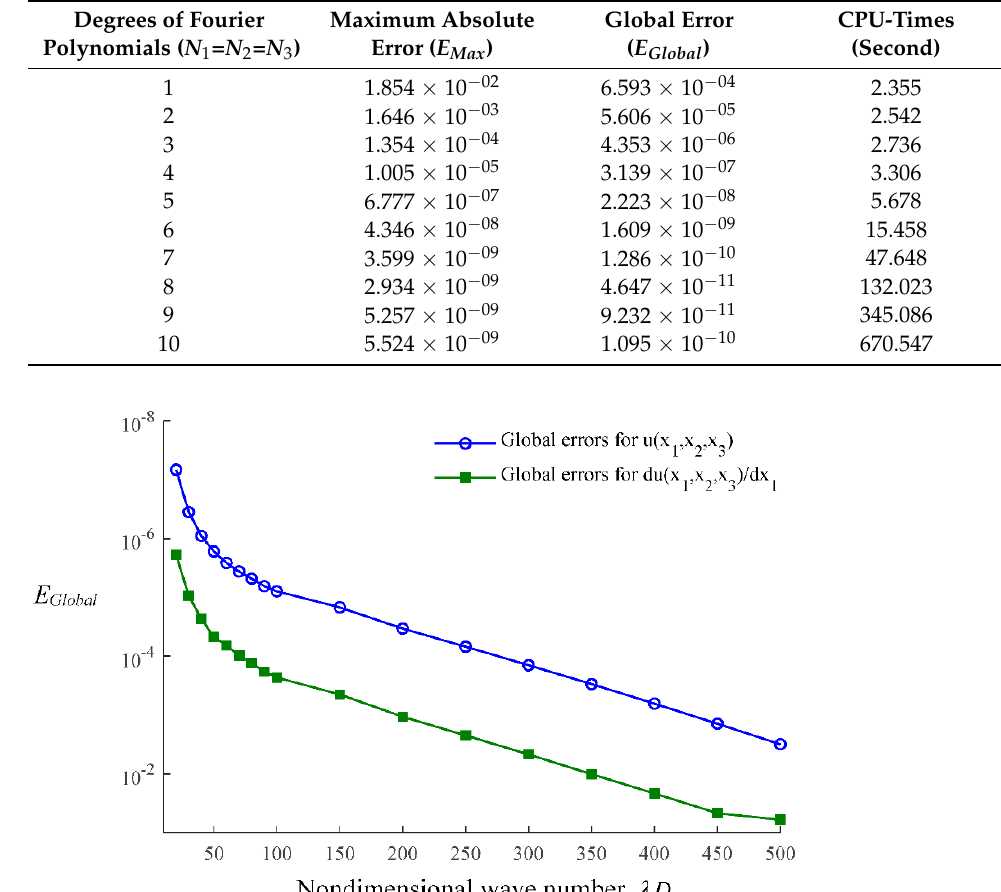
Figure 12. The profile of the five pieces fan blade domain, where “O” and “ • ” denote the source points (MFS) and boundary points, respectively. Table 4. Numerical results with respect to various degrees of Fourier polynomials.